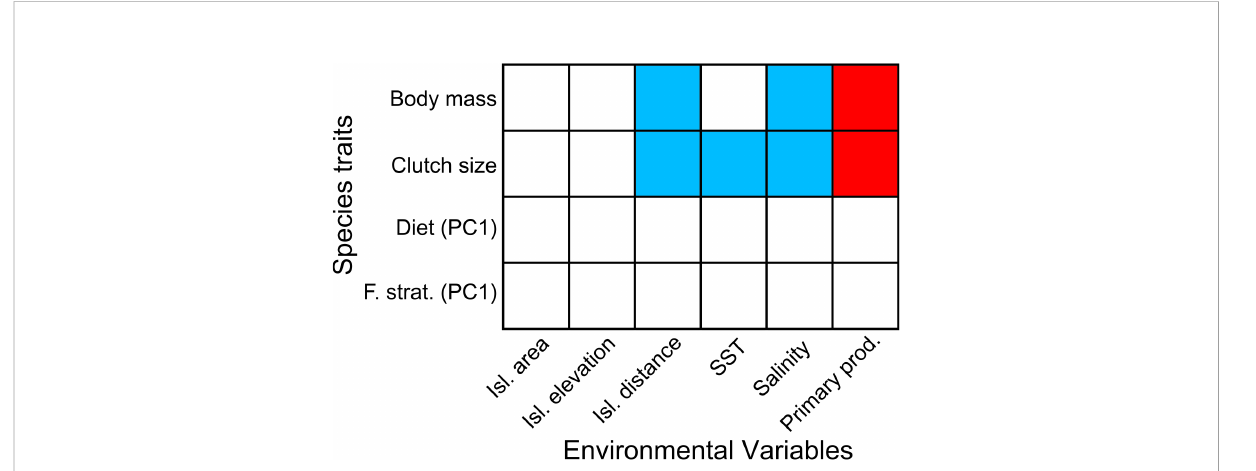
FIGURE 4 Results of the fourth-corner statistics analysis depicting the signi fi cant (p < 0.05) correlation between seabird traits (rows) and environmental variables (columns). Cell colors indicates if the correlations were positive (red) or negative (blue). Isl. = islands; SST = Sea surface temperature; prod. = productivity; F. strat. = Feeding stratum; PC1 = a vector after principal component analysis (see 2.2. for details and Supplementary Material Table